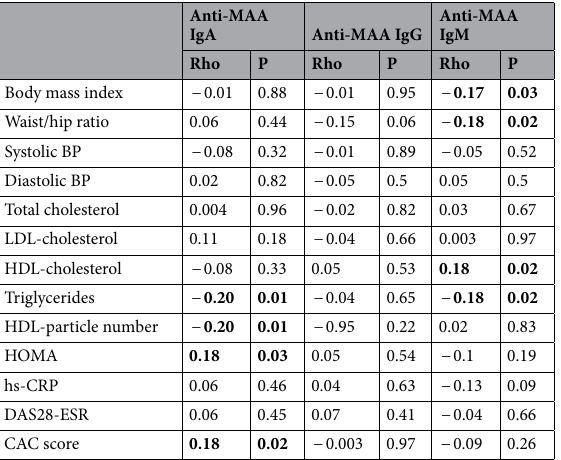
Table 2. Relationship between serum anti-MAA antibody isotype concentration and cardiometabolic measures in patients with RA. Significant values are in [bold].